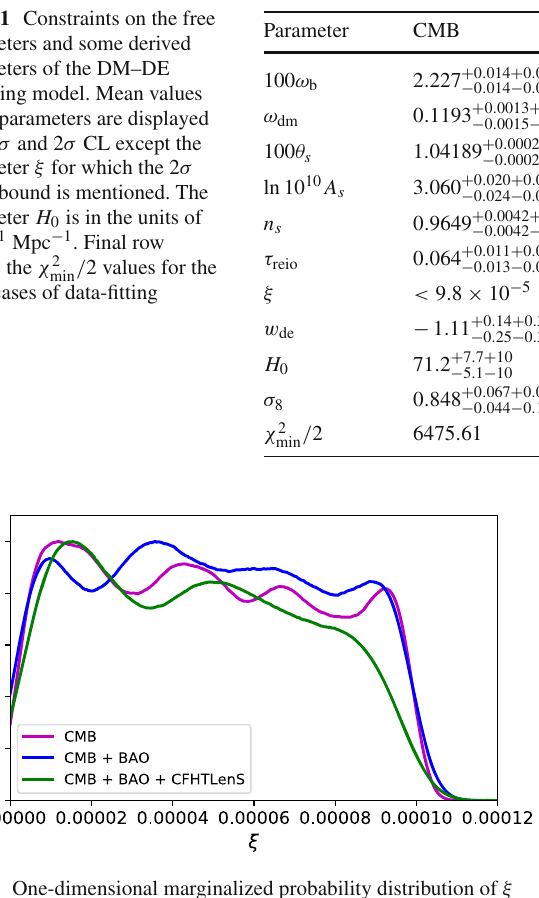
Fig. 1 One-dimensional marginalized probability distribution of ξ